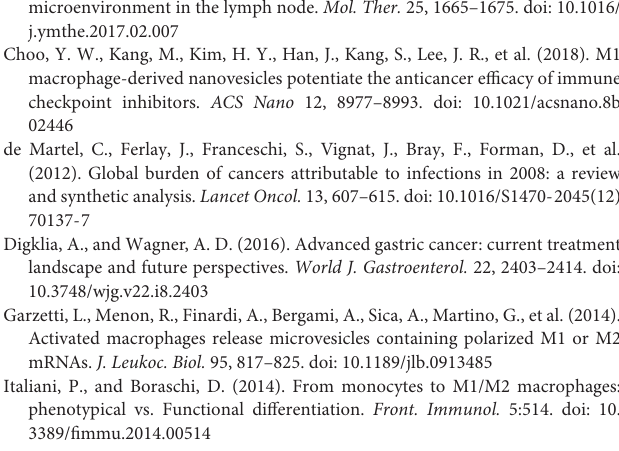
Supplementary Figure 1 | (A) The absorption of exosomes into NCI-N87 cells observed by an inverted microscope (200 × ). (B) Representative images of tumors in mice after tail injection of NCI-N87 cells co-cultured with GC or M1 exo as well as tumor volume and weight ( n = 5). (C) The expression of PD-L1 in the tumor of mice in different groups detected by Western blot analysis ( n = 5). ∗ p < 0.05 versus Control or M1 exo or GC + PBS or blank groups. (D) The expression of cytokines IL-2, TNF- α , and INF- γ in mice detected by ELISA ( n = 5). (E) Representative images of tumors in mice after treatment of exo, T cells, exo-miR-16-5p inhibitor, or anti-PD-L1 as well as quantification of tumor volume and weight ( n = 5). The data in the figure were measurement data, expressed as mean ± standard deviation. Unpaired t -test was used for comparison between two groups, and one-way ANOVA was used for comparison of data between multiple groups followed by Tukey’s post hoc test. Data between groups at different time points were compared using repeated measures ANOVA followed by Bonferroni’s post hoc test. Supplementary Figure 2 | (A) The expression of PD-L1 on the surface of NCI-N87 cells after co-culture with different groups of exosomes detected by flow cytometry. (B) The proliferation of T cells after co-culture of NCI-N87 cells treated with different groups of exosomes with T cells for 24 h detected by flow cytometry. (C) The number of activated INF- γ + T cells after co-culture of NCI-N87 cells treated with different groups of exosomes with T cells detected by flow cytometry for 24 h. (D) The expression of cytokines in the supernatant of NCI-N87 cells co-cultured with T cells in different groups detected by ELISA. ∗ p < 0.05 versus exo-mimic-NC group; # p < 0.05 versus